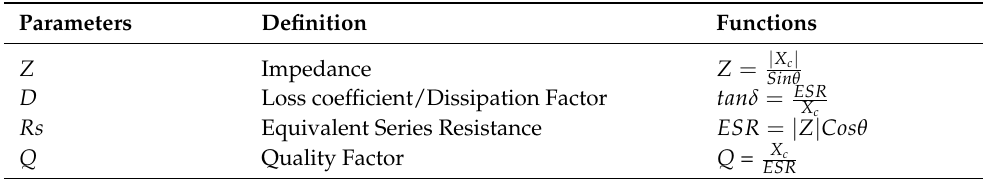
Figure 2. The proposed condition monitoring framework for the SMPS Aluminum Electrolytic Capacitors. Table 1. The Feature Set